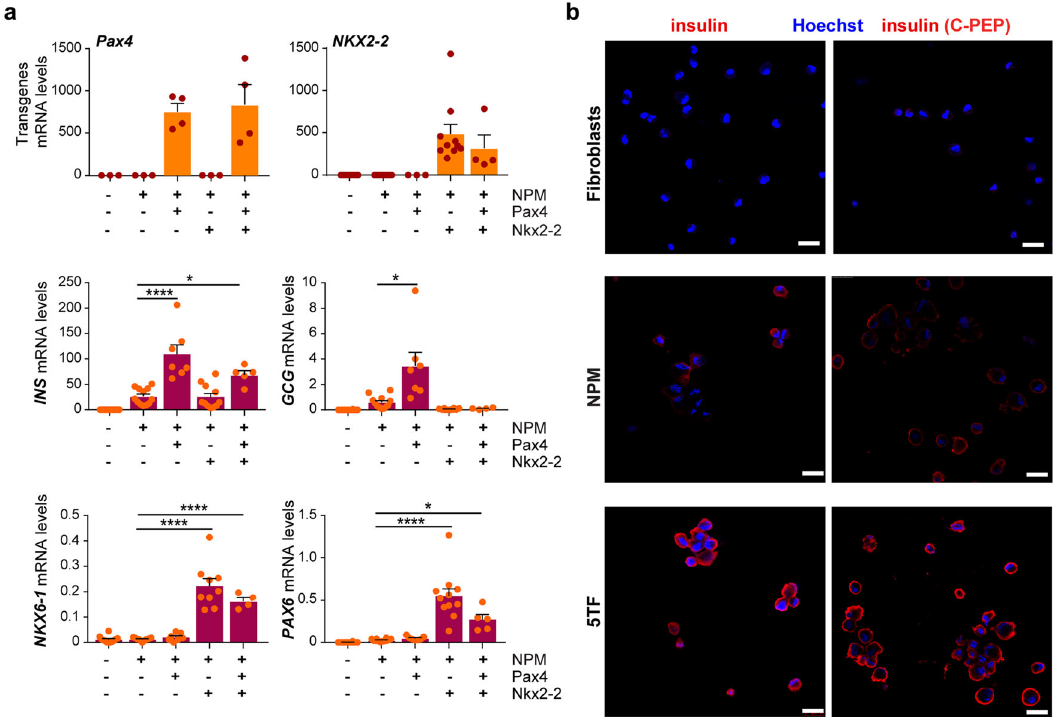
Fig. 2 Sequential addition of the transcription factors Pax4 and Nkx2-2 enhances β -cell fate in human fi broblasts expressing Neurog3, Pdx1, and MafA. Human fi broblasts (HFF1) were infected with Ad-NPM alone or sequentially with Ad-NPM and adenoviruses encoding the transcription factors Pax4 and Nkx2-2. Ad-Pax4 and Ad-Nkx2-2 were added three days after NPM in the two-virus conditions. In the three-virus condition, Pax4 was added three days and Nkx2-2 and six days after NPM (condition called 5TF). All cells were collected ten days after infection with Ad-NPM. a qPCR of the indicated transgenes and endogenous genes. Expression levels are calculated relative to TBP . Values represent the mean ± SEM ( n = 4 – 12). b Representative immuno fl uorescence images showing insulin staining (in red) using two different antibodies, one against C-PEP, in untreated fi broblasts and in fi broblasts infected with Ad-NPM alone or with 5TF. Nuclei were stained with Hoechst (in blue). Scale bar, 25 μ m. * P < 0.05; **** P < 0.0001 relative to NPM in ( b ) using one-way ANOVA and Tukey ’ s multiple comparison